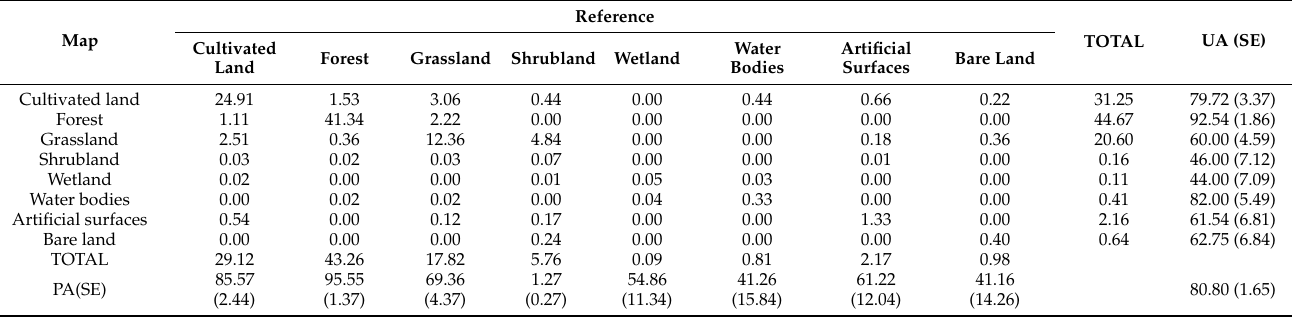
Table A2. Error matrix of GlobeLand30